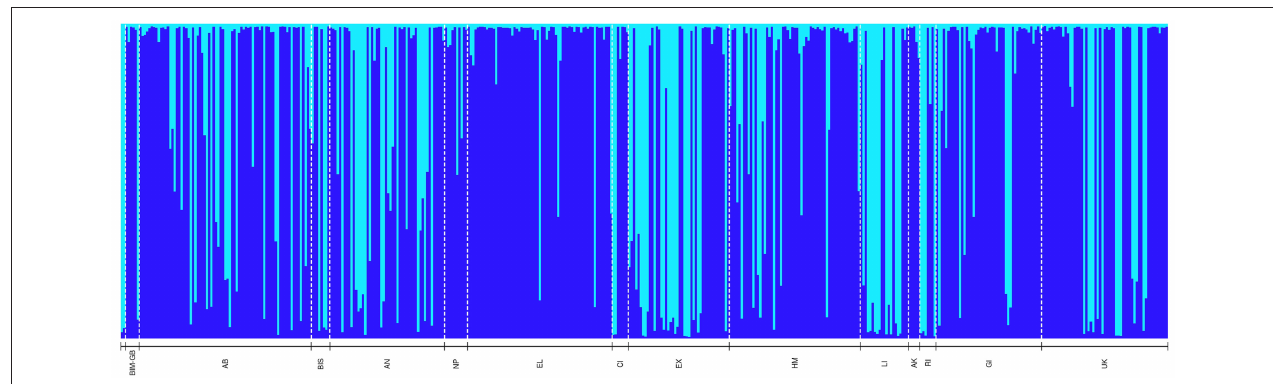
FIGURE 3 | Bayesian-based Structure analysis depicting genetic clustering ( K = 2) of 454 Nassau grouper sampled organized geographically from north to south (left-right) throughout The Bahamas ( n = 454). Codes correspond to the following sampling locations: BIM-GB includes pooled samples from Bimini ( n = 1) and GB = Grand Bahama ( n = 5), AB, Abaco; BIS, Berry Islands; AN, Andros; NP, New Providence; EL, Eleuthera; CI, Cat Island; EX, Exuma; HM, Hail Mary FSA; LI, Long Island; AK, Acklins; RI, Ragged Island; GI, Great Inagua; UK, Unknown.